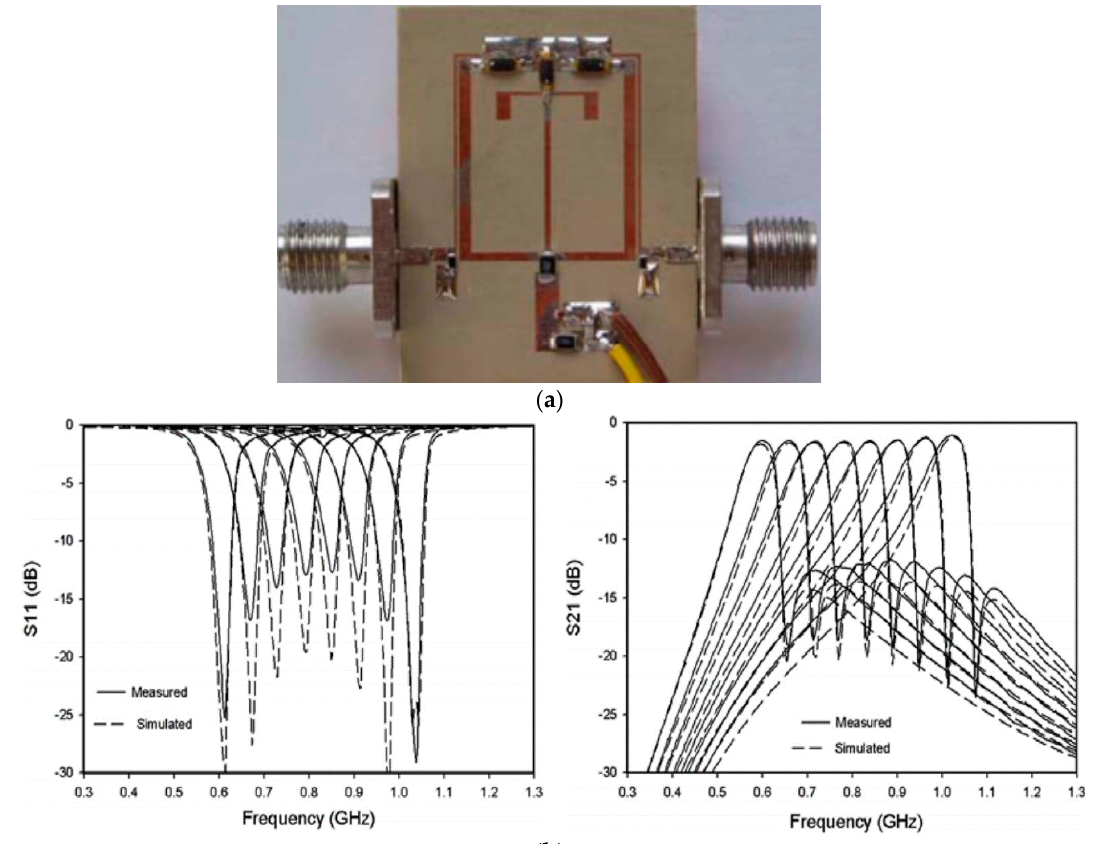
Figure 2. The reconfigurable filter reproduced from [29]. 2020, IEEE: ( a ) prototype structure; ( b ) S-parameter performance.